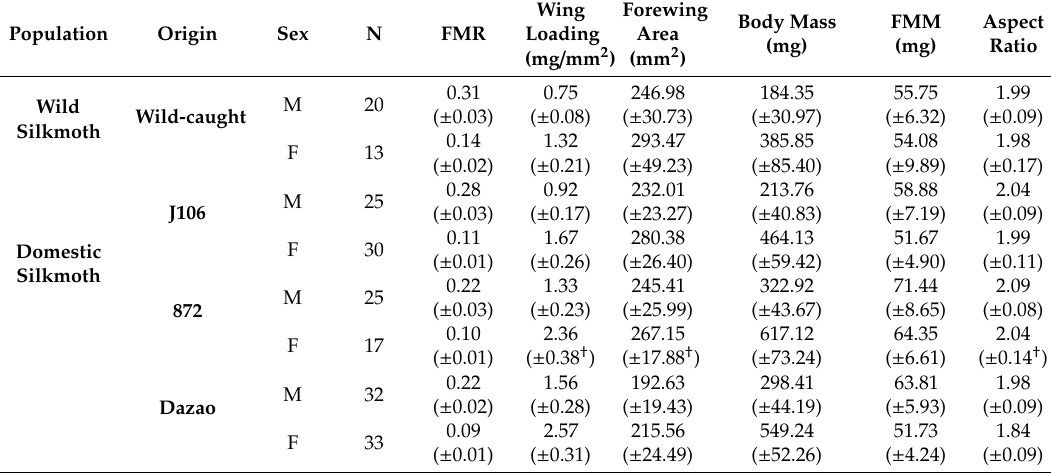
Table 1. Numbers of measured individuals and mean ( ± SD) values of morphological characteristics. Means were shown separately for males and females. Results of Analysis of Variance (ANOVA) tests of the measurements are shown in Tables 2 and 3. Abbreviated letters and digital superscript are indicated by footnotes.